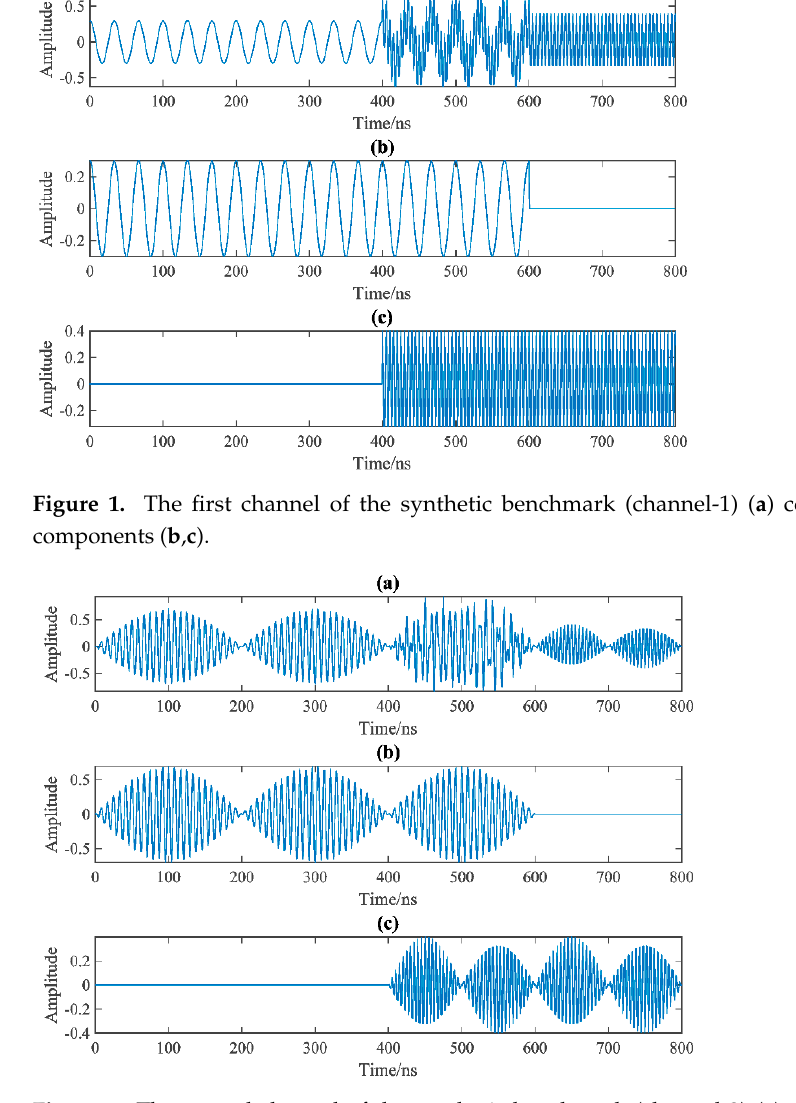
Figure 2. The second channel of the synthetic benchmark (channel-2) ( a ) composed of two sub-com- ponents ( b , c ). components ( b , c